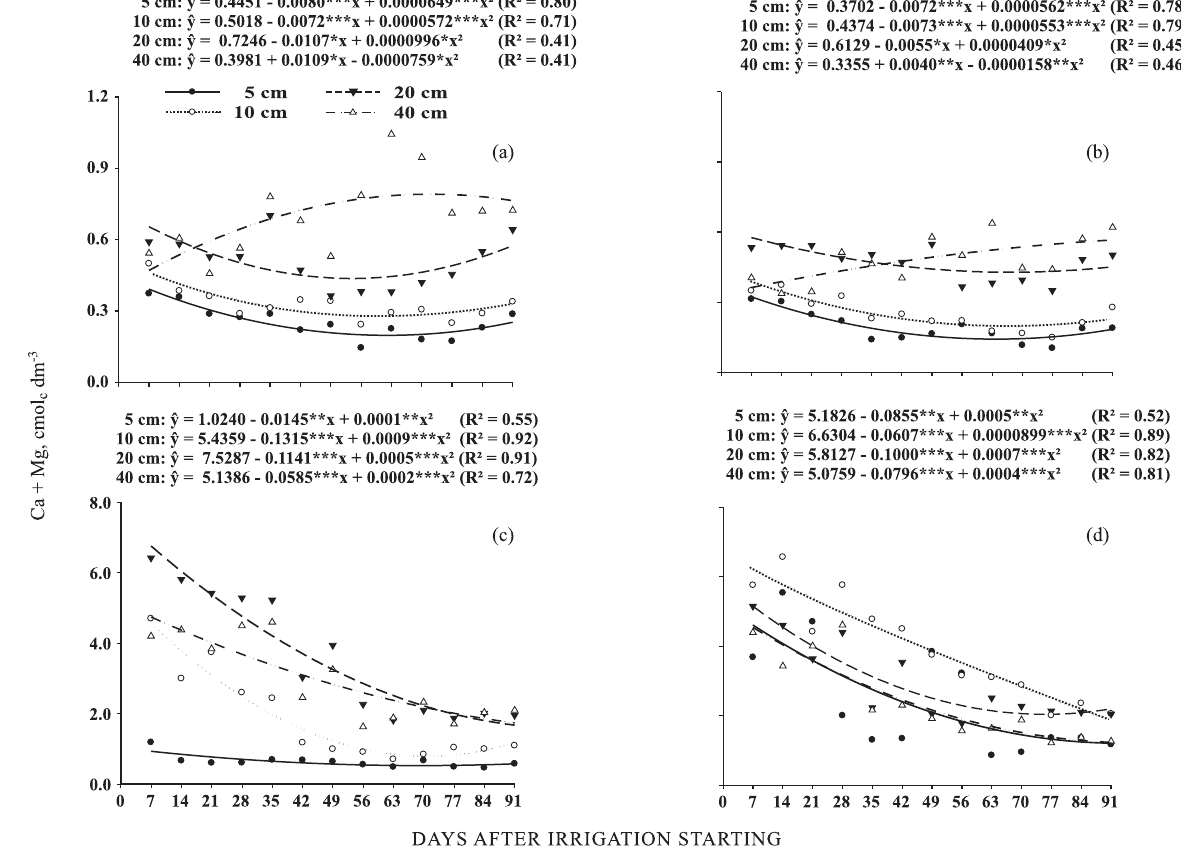
Figure 5. Calcium + magnesium concentration in the soil solution at different depths and salinity levels: Casamento (a) Cavalhada (b) Banhado (c) Sinval (d). *, **, ***: significant at 10, 5 and 1 %, by the F-test,